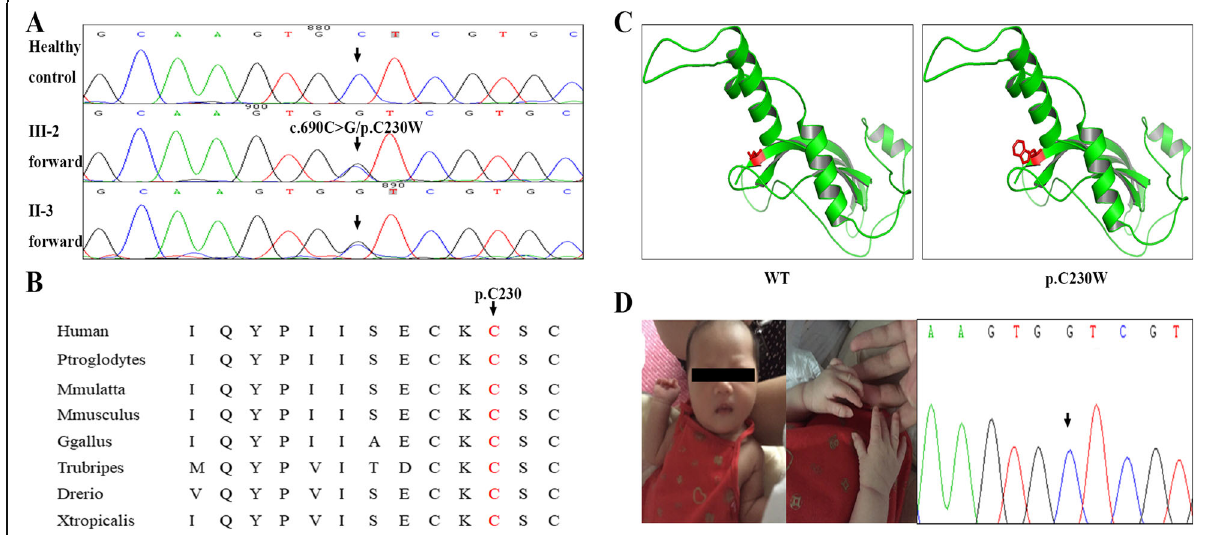
Fig. 2 Genetic analysis of the family. a Sanger DNA sequencing chromatogram demonstrates the heterozygosity for a NOG mutation (c.690C > G/ p.C230W). b Analysis of the mutation and protein domains of Noggin. The C230 affected amino acid locates in the highly conserved amino acid region in different mammals (from Ensembl). The black arrow and red words show the C230 site. c Swiss-model analyzed the Noggin structures of WT and Mutated (p.C230W). d The healthy hands of III-3 and normal sequences of amniotic fluid